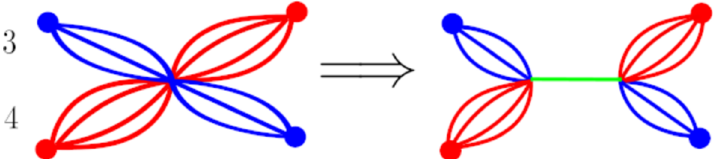
Figure 11 . At the wall of marginal stability a BPS multiparticle state with electric-magnetic charge q 0 (0 , 1) + p 0 (2 , − 1) and q 0 /p 0 > 0 (here depicted for q = 4 and p = 3 ) could reduce its mass by producing a ( p 0 , q 0 − p 0 ) -string (green) in the middle if this string were parametrically light. But this cannot be the case because (0 , 1) and (2 , − 1) are mutually